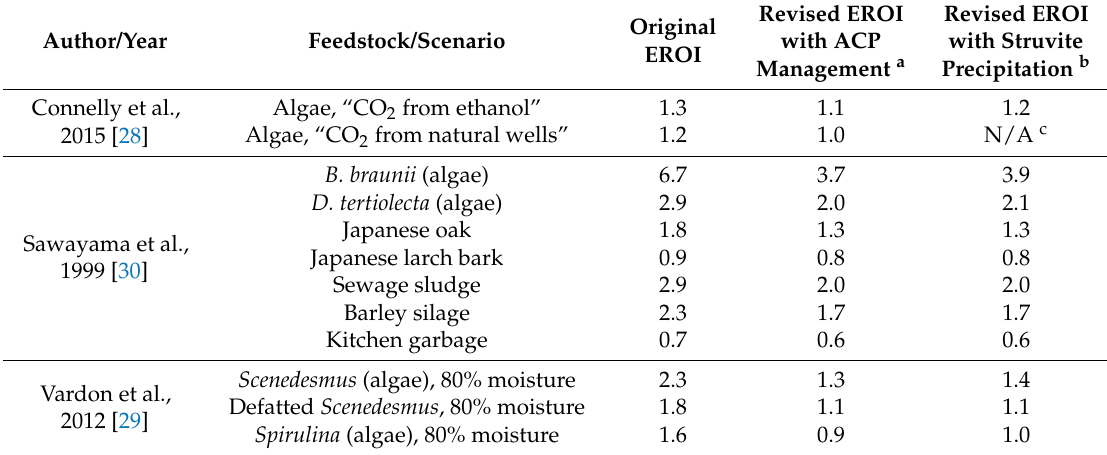
Figure 2. Calculated energy return on investment (EROI) values of nutrient removal and recovery of post-HTL ACPs of select waste feedstocks via struvite recovery. post-HTL ACPs of select waste feedstocks via struvite recovery. Table 4. Three sets of EROI values for HTL processing of various organic feedstocks: as reported in original HTL studies; as revised by Bauer et al. (2018) [4] to include ACP management in a conventional wastewater treatment plant (WWTP); and as re-revised in this study to account for nutrient recovery via struvite precipitation with subsequent conventional treatment to remove residual TN, TP, and biological oxygen demand